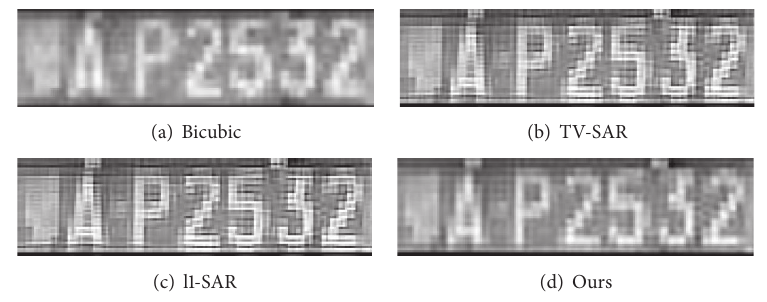
Figure 14: The reconstructed results for the first LR license plates.